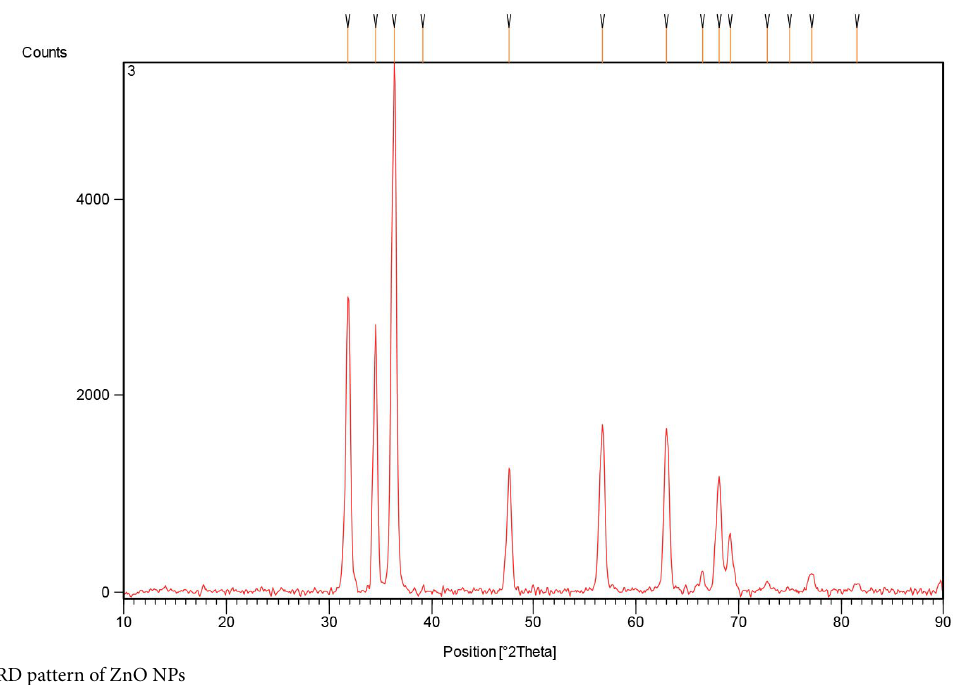
Figure 4. XRD pattern of ZnO